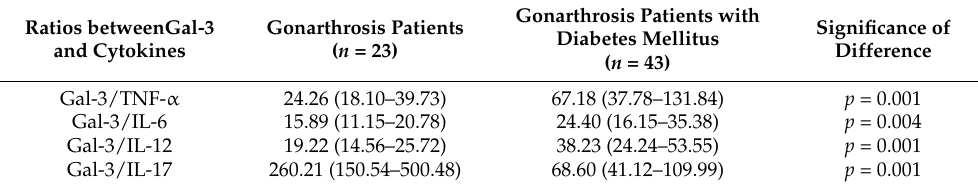
Table 4. Gal-3/TNF- α , Gal-3/IL-6 and Gal-3/IL-12 and Gal-3/IL-17 (median and interquartile range) in gonarthrosis patients with and without diabetes melitus.